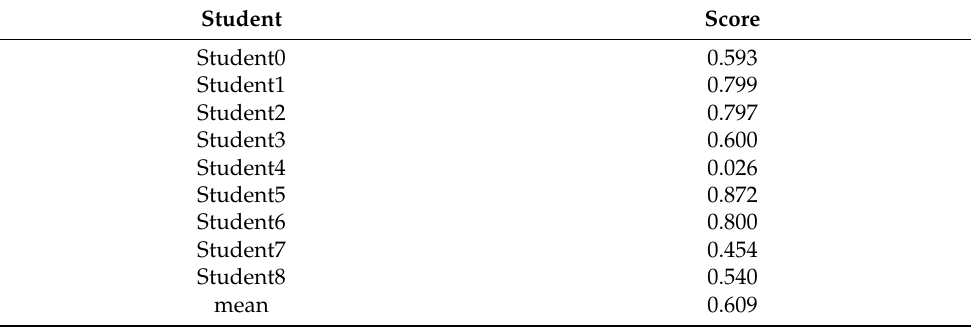
Table 3. Scores of students’ learning